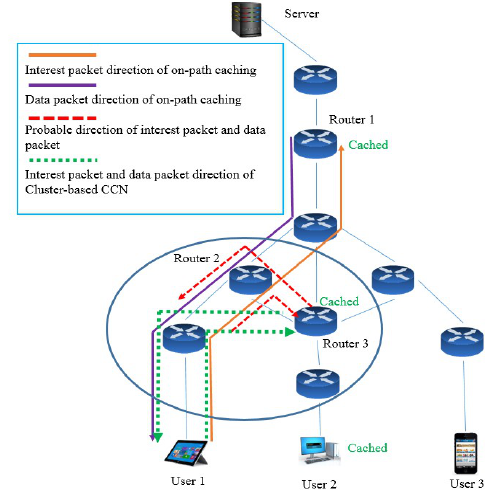
Figure 6. Enhanced on-path caching.